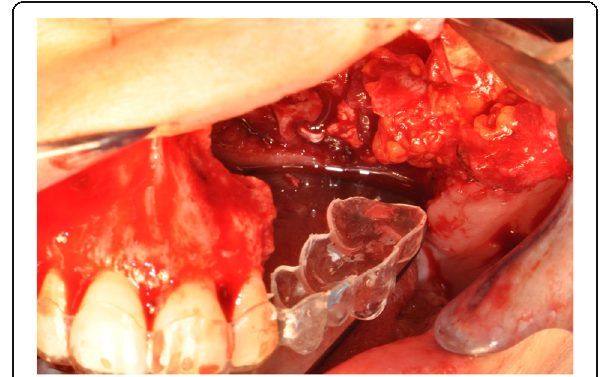
Fig. 9 Pt no. 2. The prefabricated occlusal replica used for correct zygomatic implant emergence